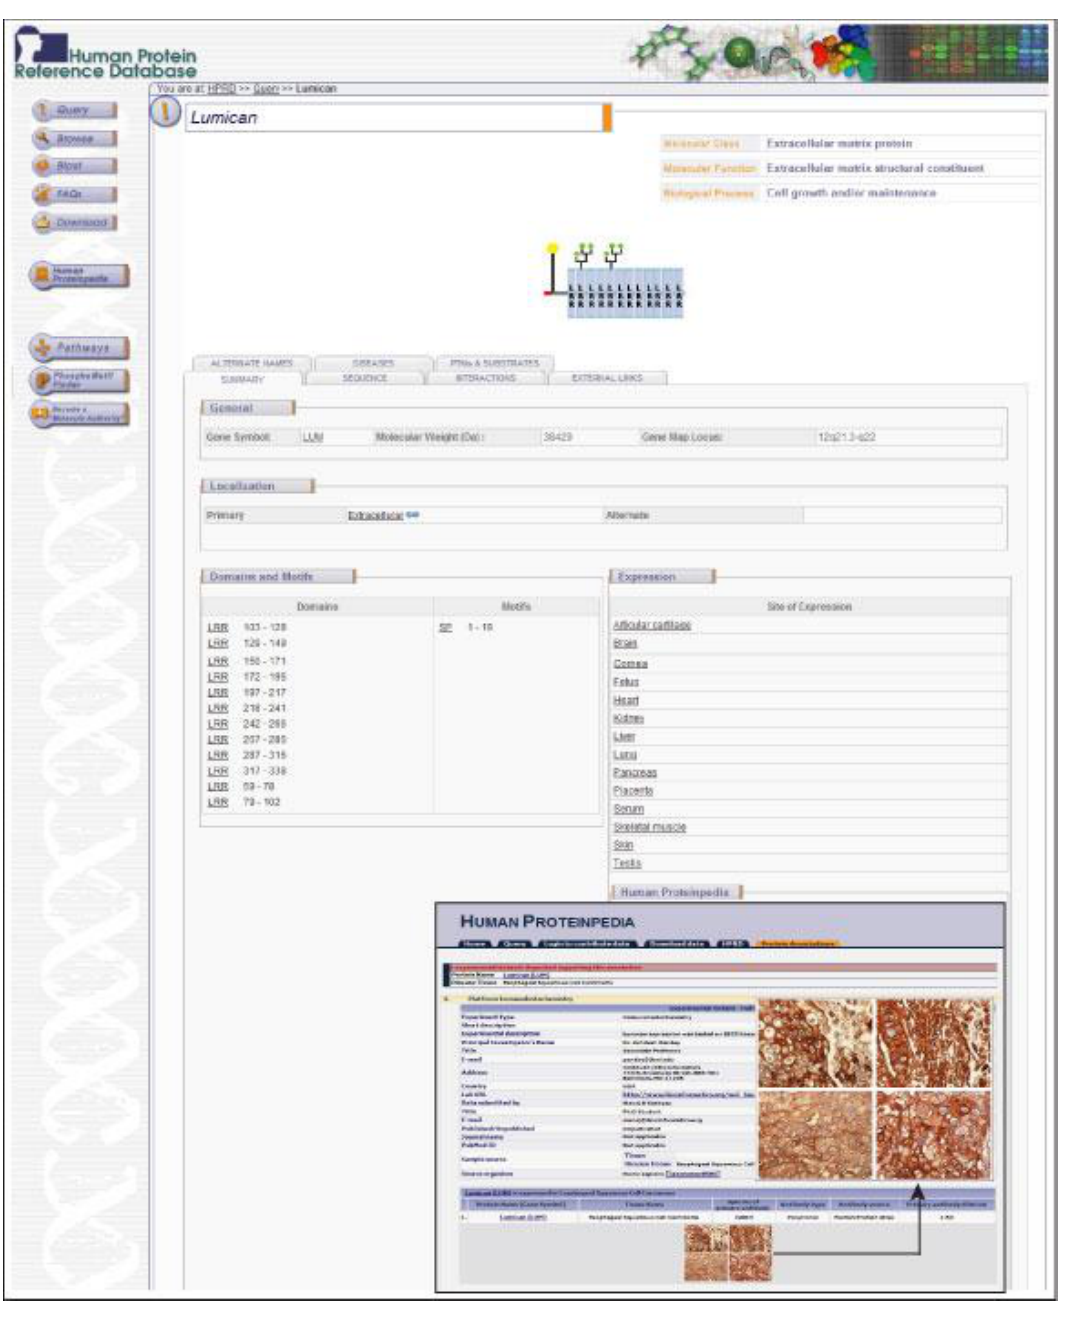
Figure 4. A snapshot of lumican annotation in human Proteinpedia. Shown here is the data for lumican from human Proteinpedia with permission, a public portal that provides data for a given protein from different experimental platforms. The figure shows the immunohistochemical staining of lumican in selected esophageal squamous cell carcinoma